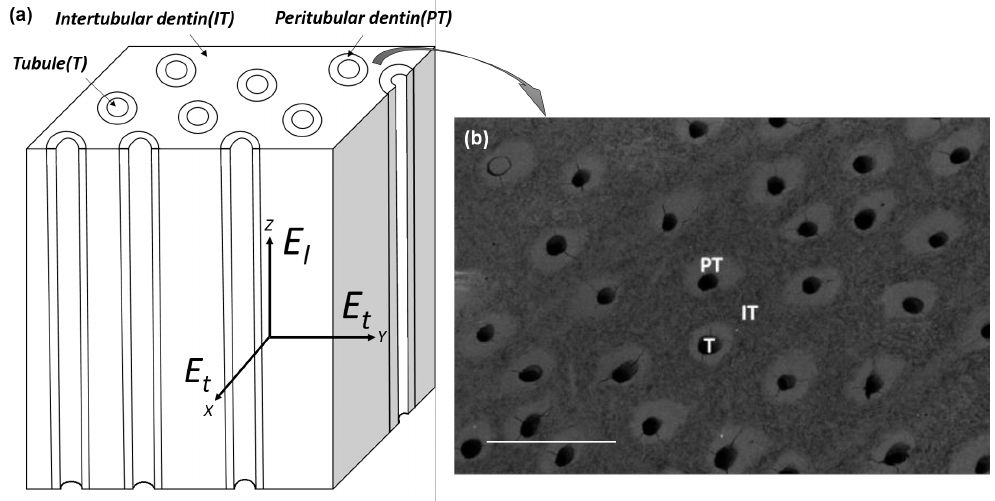
Figure 1. ( a ) Dentinal structure: the directions of longitudinal modulus ( E modulus ( E ) are shown in the scheme. ( b ) Scanning electron microscopy image from the t top view of dentin, with the identification of regions of peritubular dentin (PT), intertubular dentin (IT), and a tubule (T). Scale bar corresponds to 10 µ